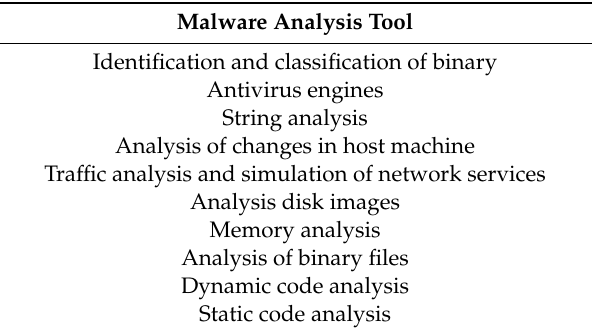
Table 1. Malware analysis